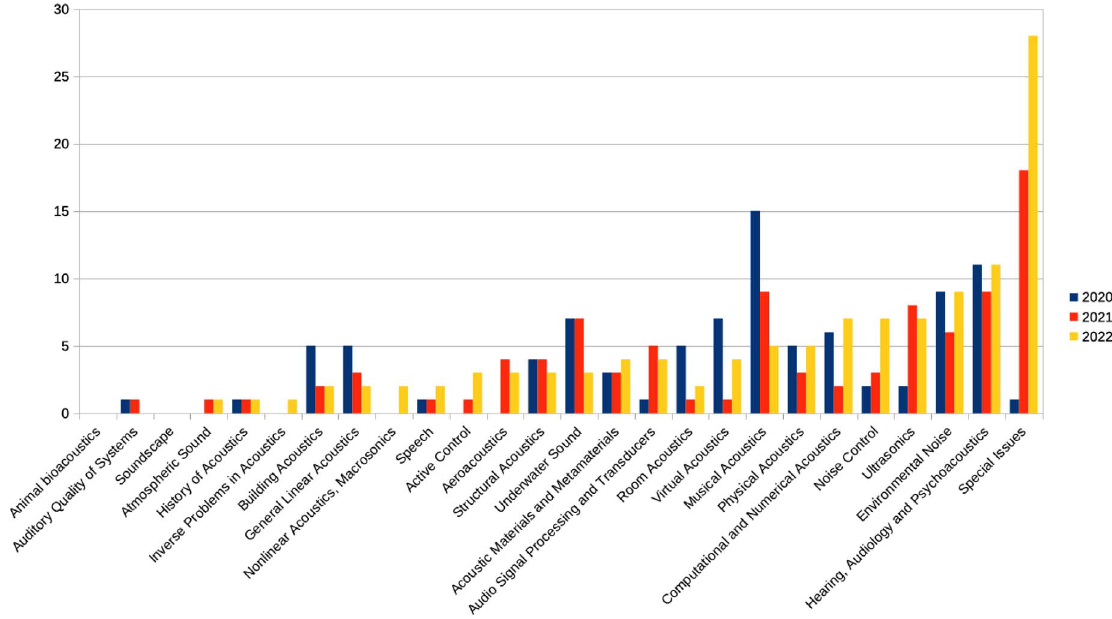
Figure 4. Submissions according to